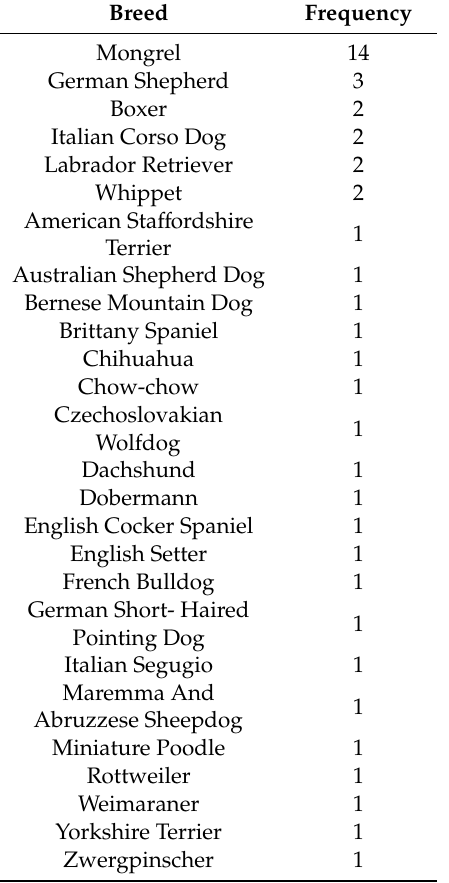
Table 1. Frequencies of various breeds in the study